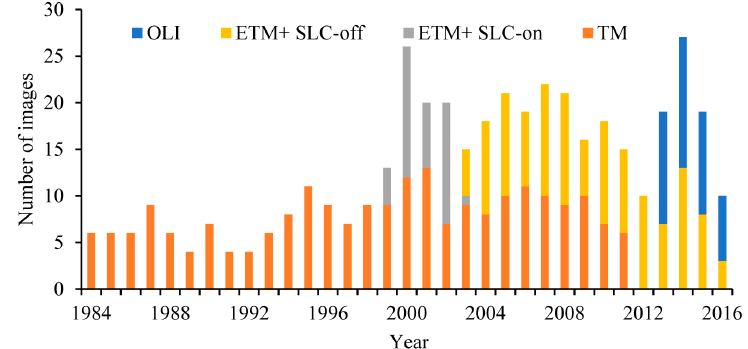
Figure 2. The number of Landsat scenes between 1984 and 2016 used in this research.